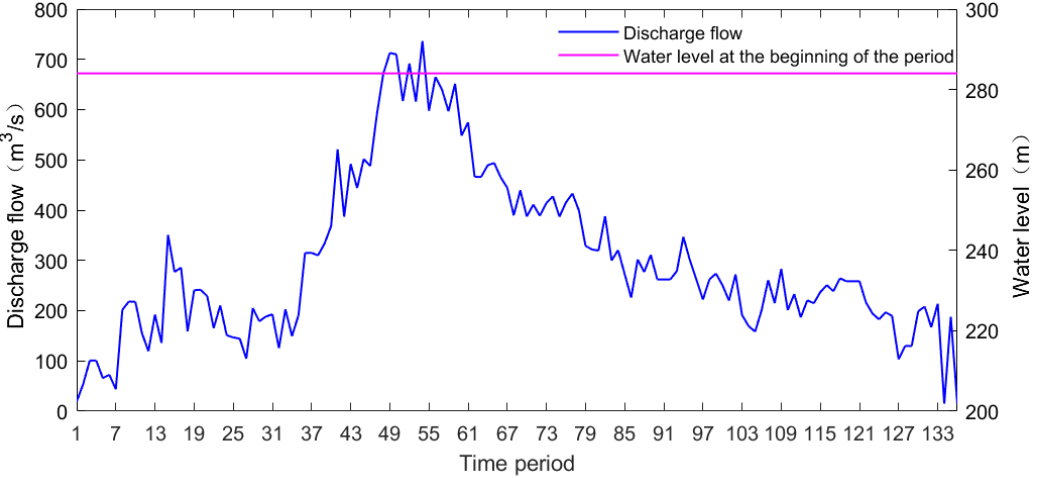
Figure 9. Conventional scheduling results of the first flood.